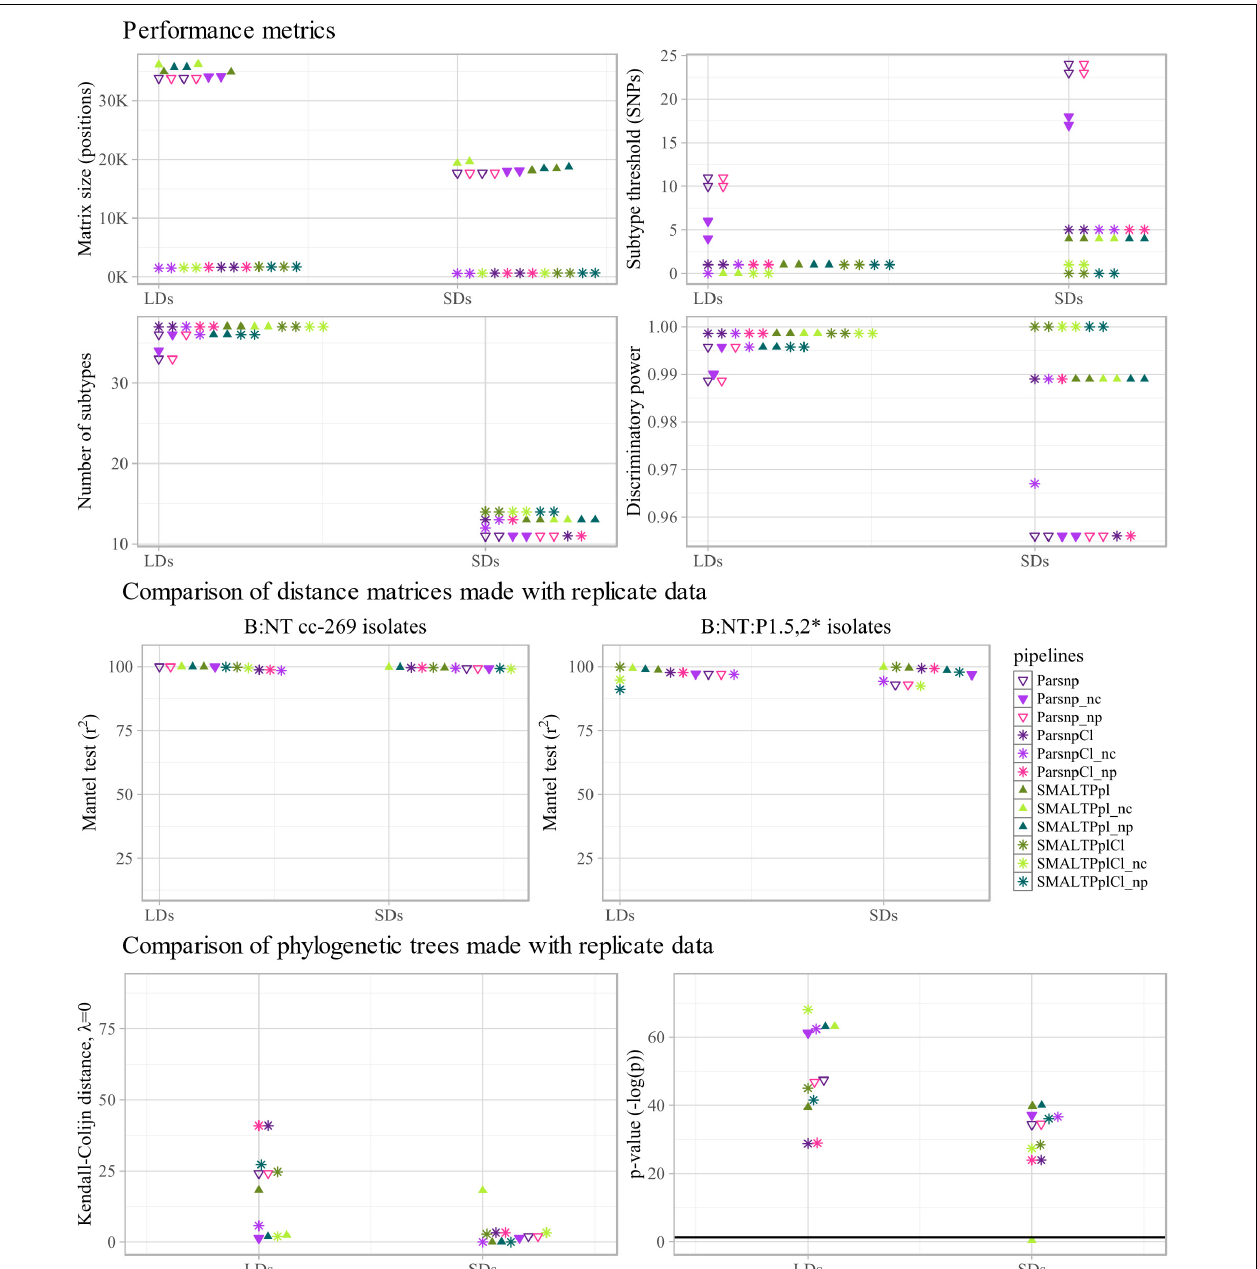
FIGURE 5 | Technical performance characteristics of subtyping workflows: reference genomes. Performance of selected pipelines, i.e., Parsnp, SMALTPpl, ParsnpCl and SMALTPplCl, with three different reference genomes, more specifically Pacbio (/), hybrid Nanopore (np) and NC017515.1 (nc) was evaluated. Upper four panels: performance metrics of the tested pipelines, more specifically SNP/allele matrix size, threshold for differentiation between subtypes, the number of subtypes discriminated by the pipelines and the corresponding discriminative power (D) observed with the different reference genomes are shown. For each metric, the values calculated with the two large datasets (LDs), two small datasets (SDs) are displayed separately along the x -axis. Middle two panels: to assess how stability of each pipeline toward inter-run variability of sequencing data is altered by the reference genomes used, distance matrices produced with replicate sequencing datasets were compared using Mantel test. For each combination of pipeline and reference genome, the comparison was carried out between the two large datasets (LDs), and the two small datasets (SDs) (indicated on the x -axis), using all B:NT cc-269 isolates (left) , as well as a subset of more closely related isolates, B:NT:P1.5,2 ∗ (right) . The resulting Spearman correlation coefficients ( r 2 ) were reported. Lower two panels: to further assess how stability of each pipeline toward inter-run variability of sequencing data is altered by the reference genomes used, phylogenetic trees produced with replicate sequencing data are compared using the Kendall–Colijn (KC) test for topology ( λ = 0). For each combination of pipeline and reference genome, the comparison was carried out between the two large datasets (LDs), and the two small datasets (SDs) (indicated on the x -axis), and the resulting KC values (left) and the corresponding p -values, expressed as –log(p) (right) , were shown. Thick horizontal line corresponds to p = 0.05